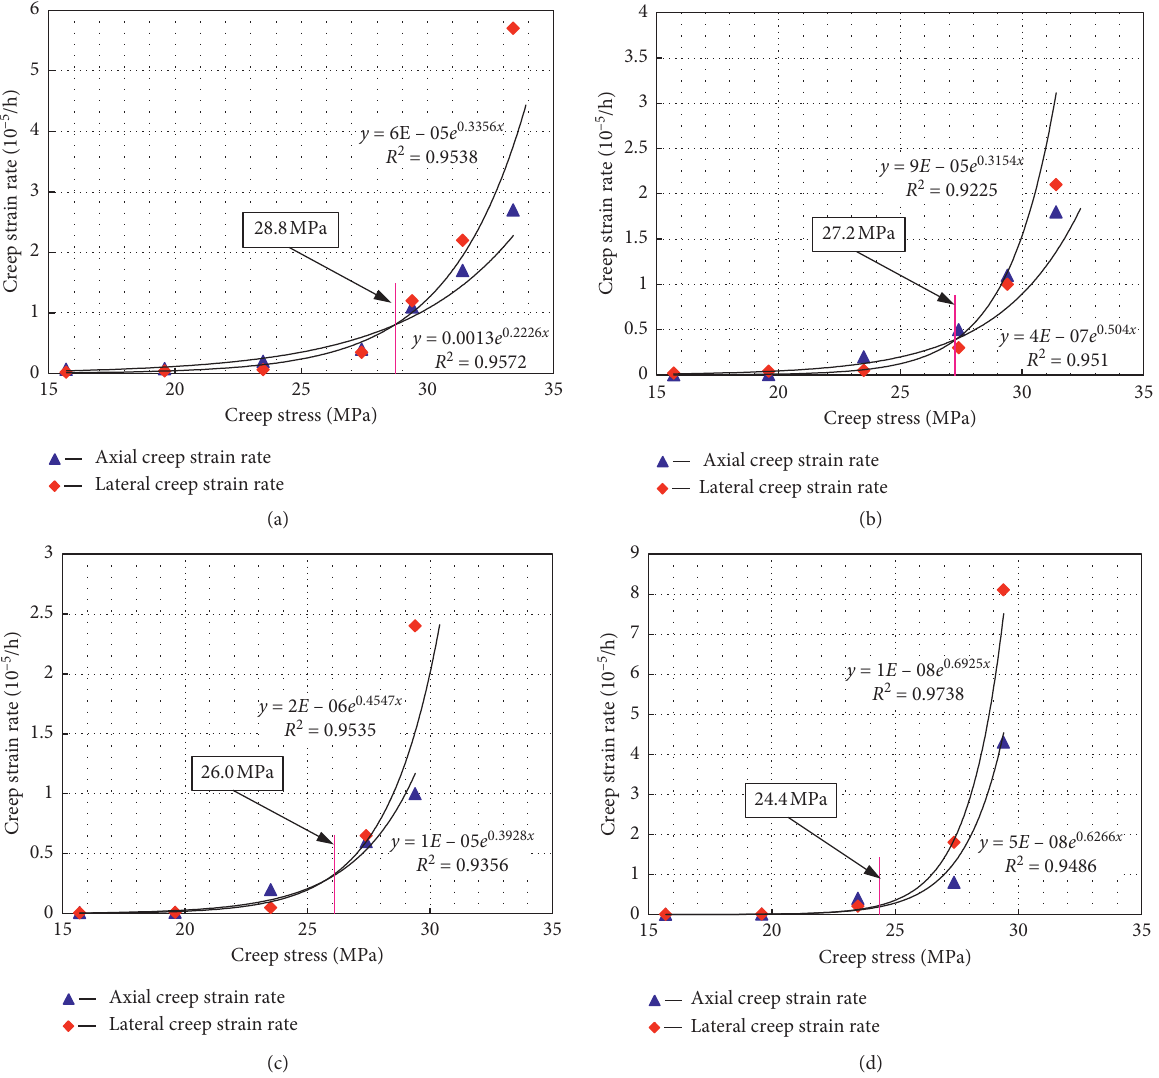
Figure 8: Intersection curves of axial and lateral steady creep rates of rock with different initial damage states: (a–d) the rock specimens with the initial damage state D 1 , D 2 , D 3 , and D 4 ,